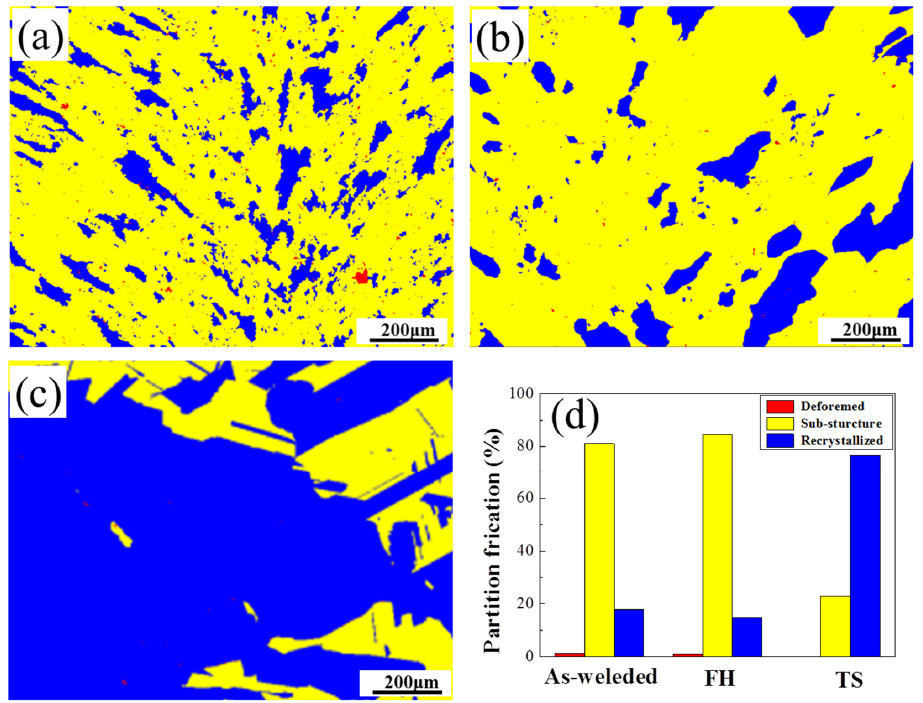
Figure 6. Grain orientation spread maps: ( a ) as-welded, ( b ) FH, and ( c ) TS samples and ( d ) the fractions of recrystallized, sub-structured, and deformed grains in the various specimens. The as-welded samples show large numbers of dislocations near the grain bounda- ries, as shown in Figure 7. It can be seen that more dislocations are distributed near the grain boundaries, and they are especially concentrated in the intersections of the triple grain boundaries. Further, the dislocations also presented within the grains. The increased dislocation density could play an important role in dislocation strengthening based on constitutive modeling [31]. The high dislocation density could presumably be understood to be a consequence of the M 23 C 6 carbides during the solidification and thermal stress from the volume change in the crystals during the cooling process. In order to further verify the particle in Figure 7b, the EDS maps are shown in Figure 8. The particle is rich in Cr, Ni, N, and C, and Mn is visible around the grain boundary. The formation of the M 23 C 6 car- bides is detrimental to the plastic deformation. With the increase in tensile stress, more secondary cracks accumulate around the M 23 C 6 carbides along the grain boundary, which leads to more crack nucleation in the as-welded joints.